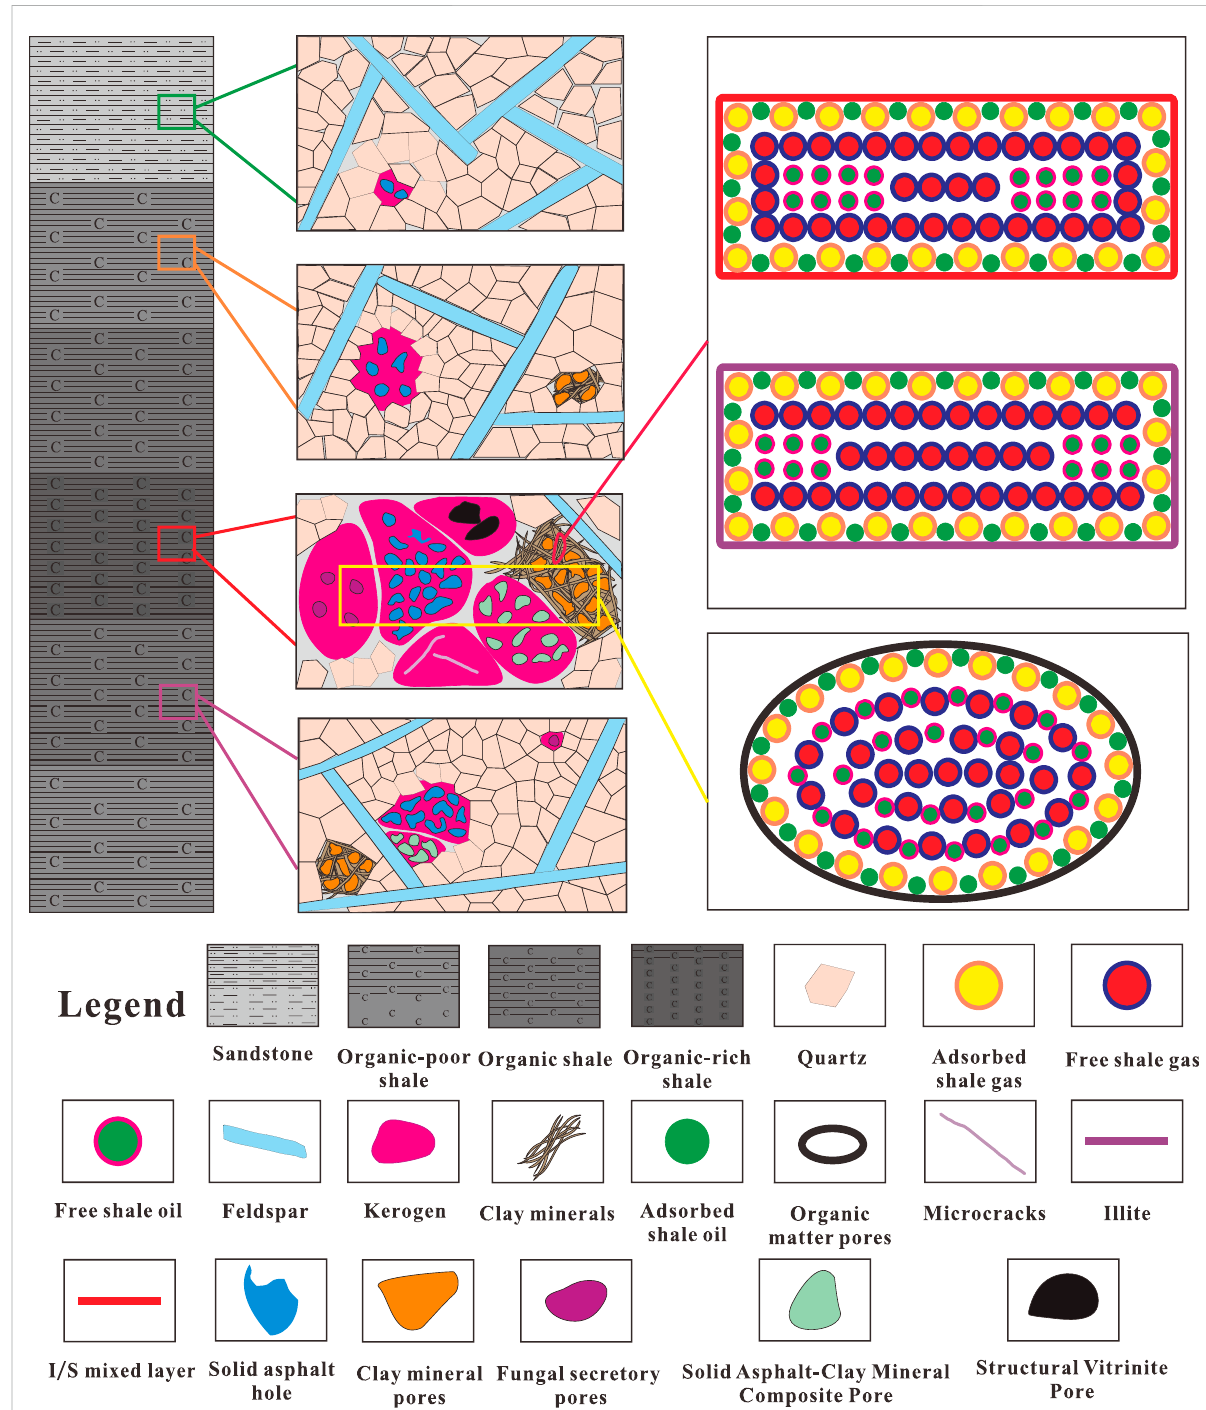
FIGURE 9 Summary of patterns of pore characteristic of medium-high maturity continental shale oil and gas